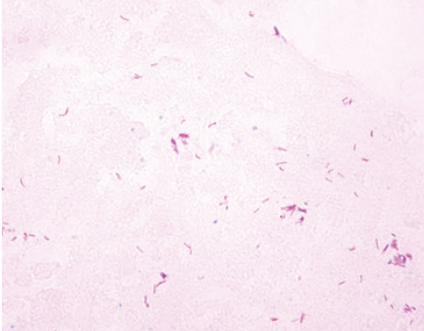
Figure 3: Scattered acid-fast bacilli on the cell block preparation (acid-fast